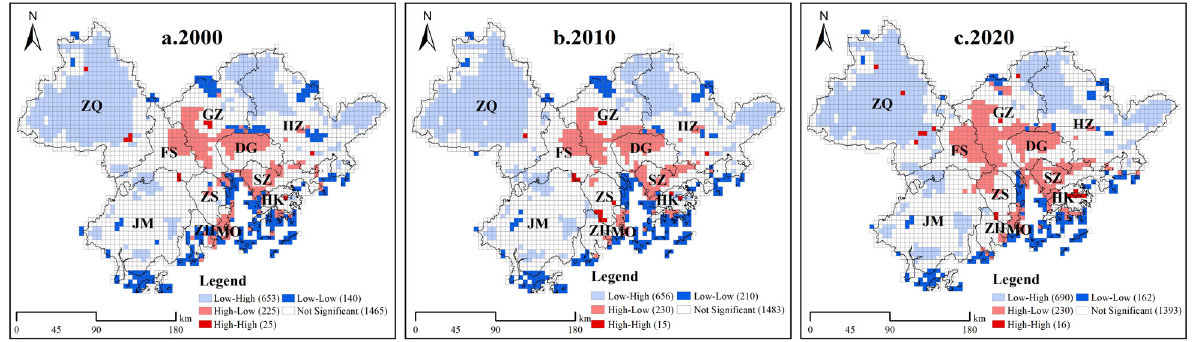
Figure 7. LISA cluster map of the UL and EHI in the GBA, 2000–2020.